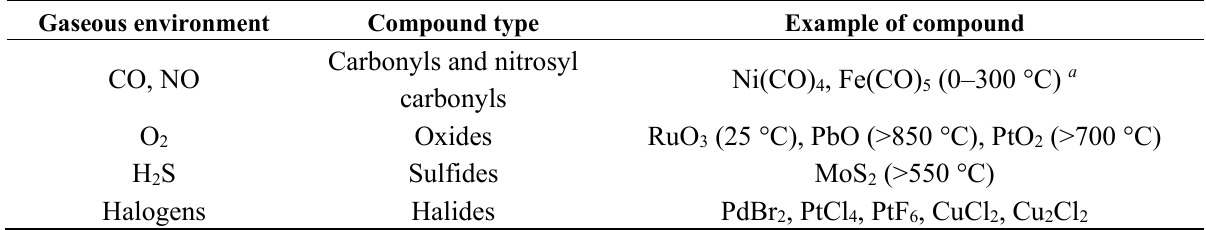
Table 12. Types and Examples of Volatile Compounds Formed in Catalytic